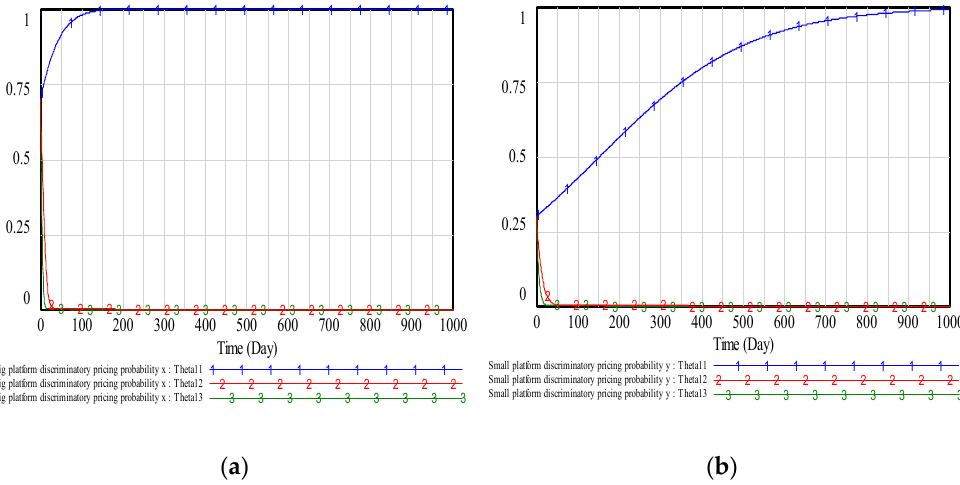
Figure 7. System simulation results of the sensitivity analysis to θ 1 . ( a ) The impact of θ 1 on